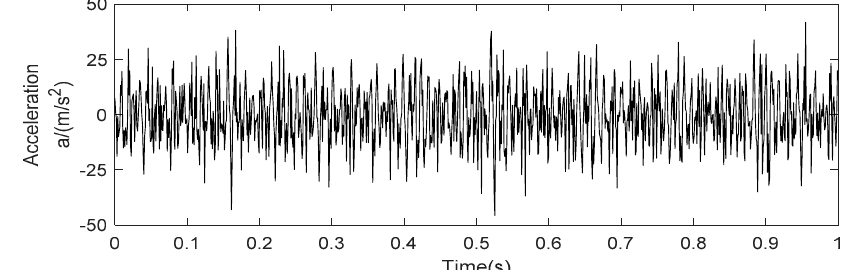
Figure 17. Time-domain waveform of fan gearbox vibration acceleration signal.